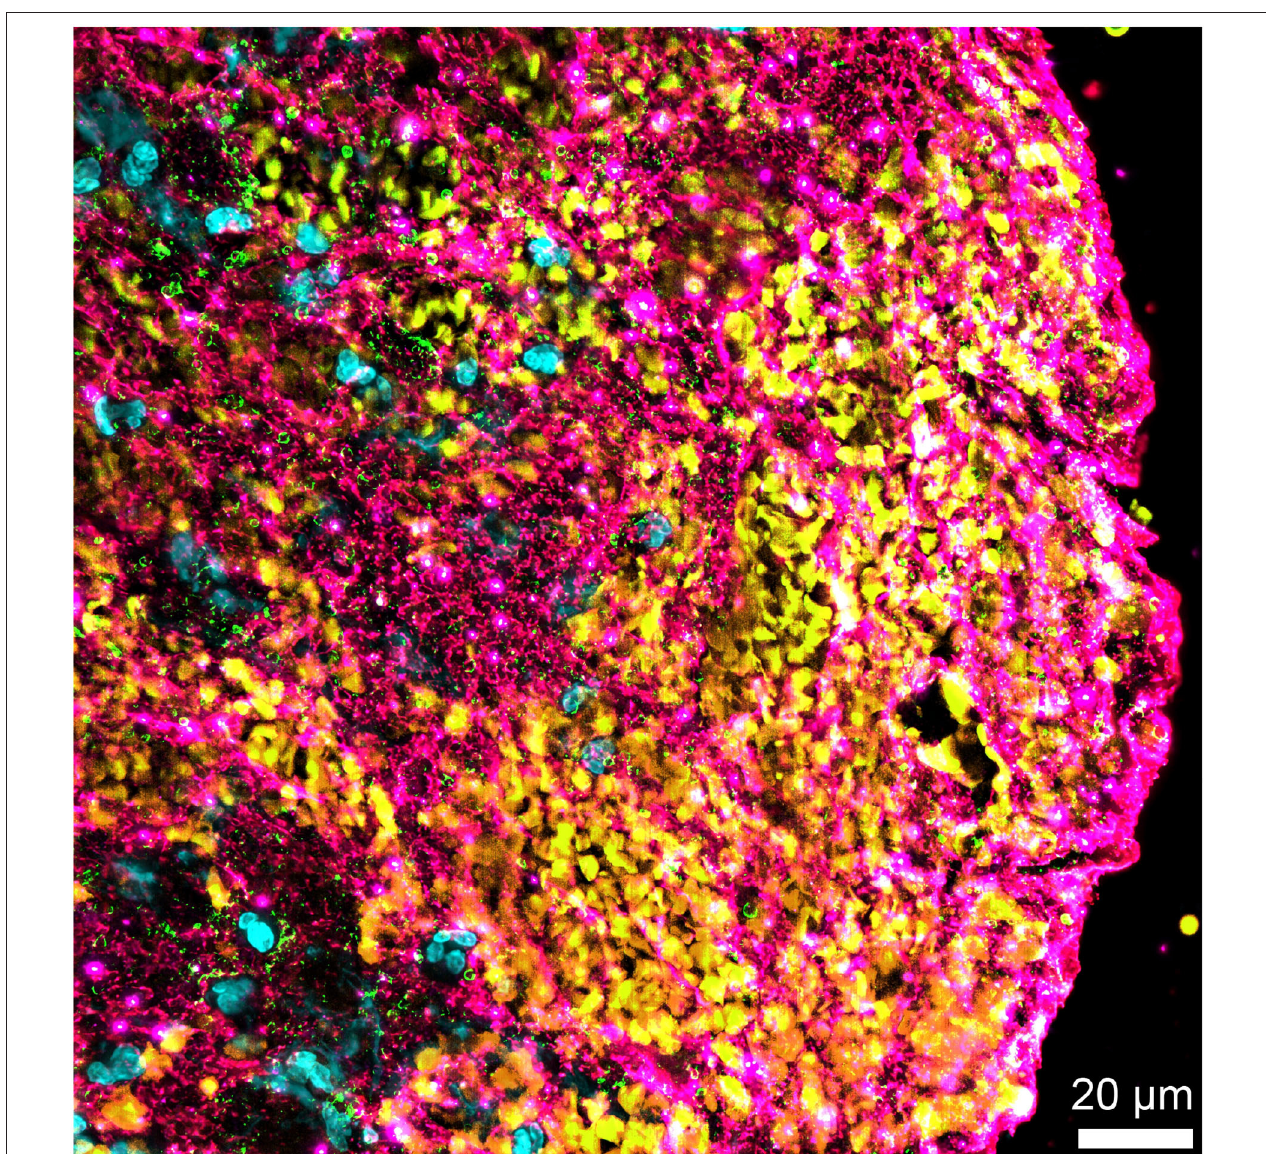
FIGURE 2 | Non-fibrin components in an acute ischemic stroke thrombus. Immunofluorescent staining of an acute ischemic stroke (AIS) thrombus for DNA (Hoechst 33342, blue), platelet glycoprotein Ib (GPIb; green), red blood cells (yellow), and von Willebrand factor (vWF) (pink) showing the abundance of non-fibrin components, several of which are potential pharmacological targets for improved